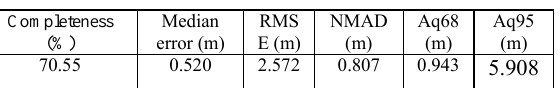
Table 2. Evaluation result of the fused DSM